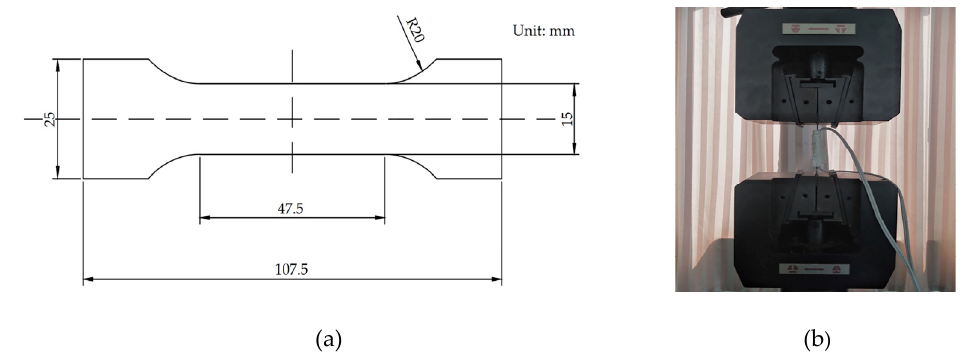
Figure 2. Tensile test: ( a ) Tensile sample size. ( b ) The tensile processes.